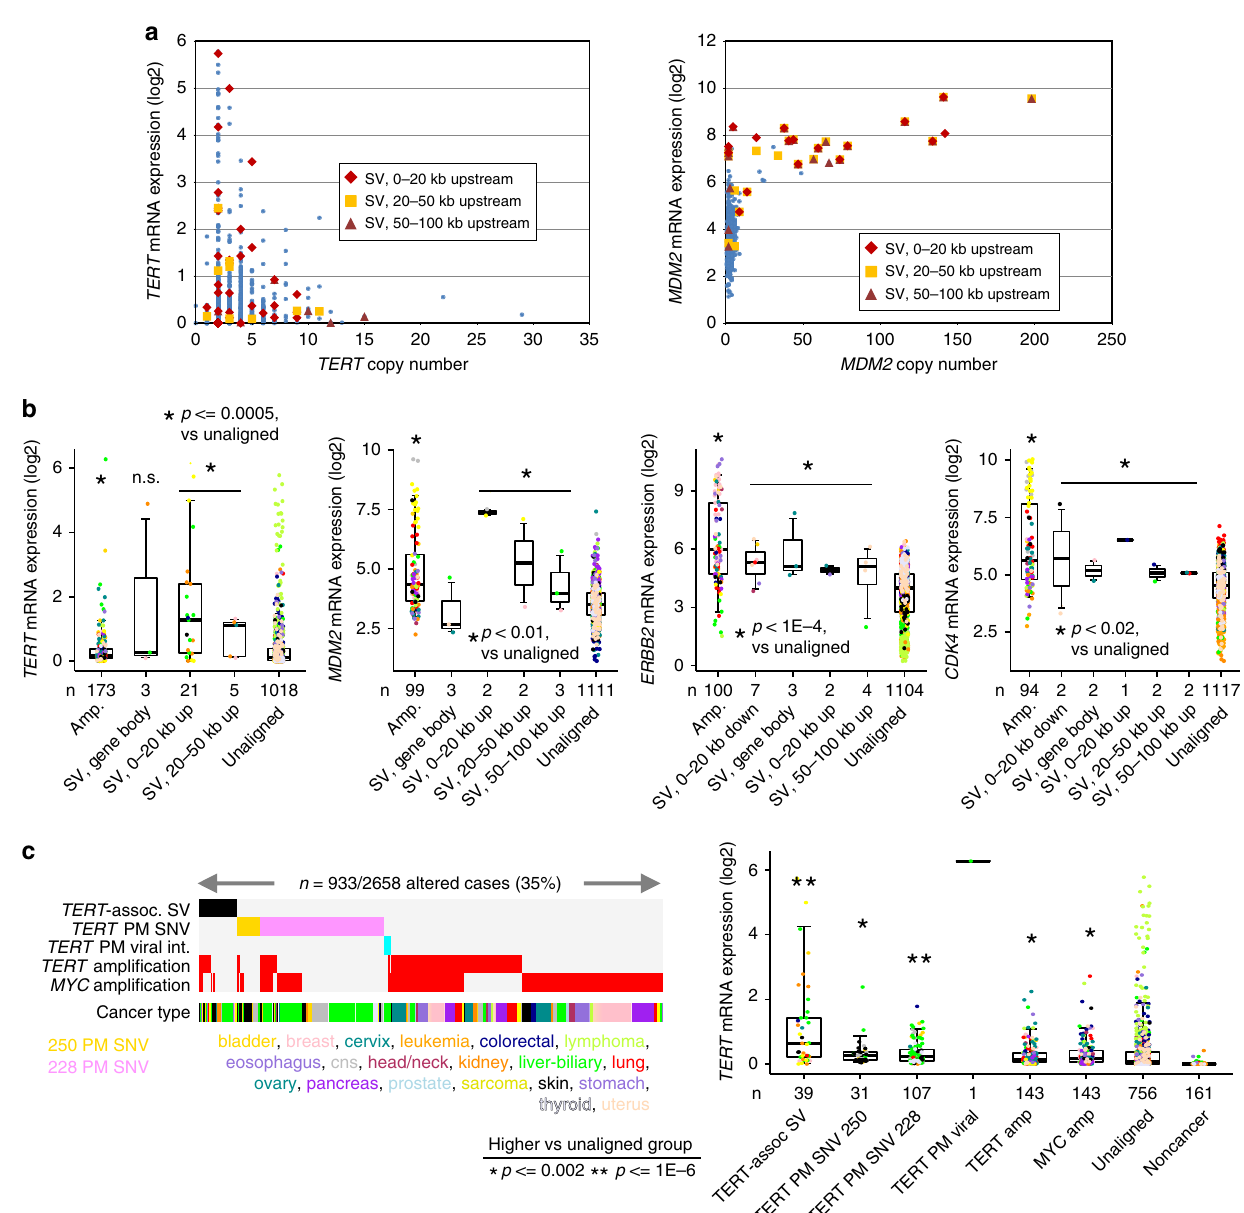
Fig. 3 SV breakpoints in proximity to key genes uniquely contribute to cases of high expression. a For 1220 cancer cases, copy number versus expression for TERT (left) and MDM2 (right). Cases with SV events upstream of the gene are indicated. b Box plots of expression for TERT , MDM2 , ERBB2 , and CDK4 by alteration class ( “ amp. ” or gene ampli fi cation: 5 or more copies, SV breakpoint within gene body, SV breakpoint 0 – 20 kb downstream of gene, SV breakpoint 0 – 20 kb upstream of gene, SV breakpoint 20 – 50 kb upstream of gene, SV breakpoint 50 – 100 kb upstream of gene, or none of the above, i.e., “ unaligned ” ). Cases with both SV breakpoint and ampli fi cation are assigned here within the ampli fi cation group. Asterisks ( “ * ” ) denote statistically signi fi cant differences versus unaligned group as indicated. c Left: Alterations involving TERT (SV breakpoint 0 – 50 kb upstream of gene, somatic mutation in promoter, viral integration within TERT promoter, 5 or more gene copies of TERT or MYC ) found in the set of 1220 cancers cases having both whole- genome sequencing and RNA data available. Right: Box plot of TERT expression by alteration class. “ TERT amp ” group does not include cases with other TERT -related alterations (SV, Single Nucleotide Variant or “ SNV ” , viral). P -values by Mann – Whitney U-test; “ * ” denotes signi fi cant differences versus unaligned group with p < = 0.002, and “ ** ” denotes signi fi cant differences with p < 1E − 6. n.s., not signi fi cant ( p > 0.05). Box plots represent 5, 25, 50, 75, and 95%. Points in box plots are colored according to tumor type as indicated in part ( c